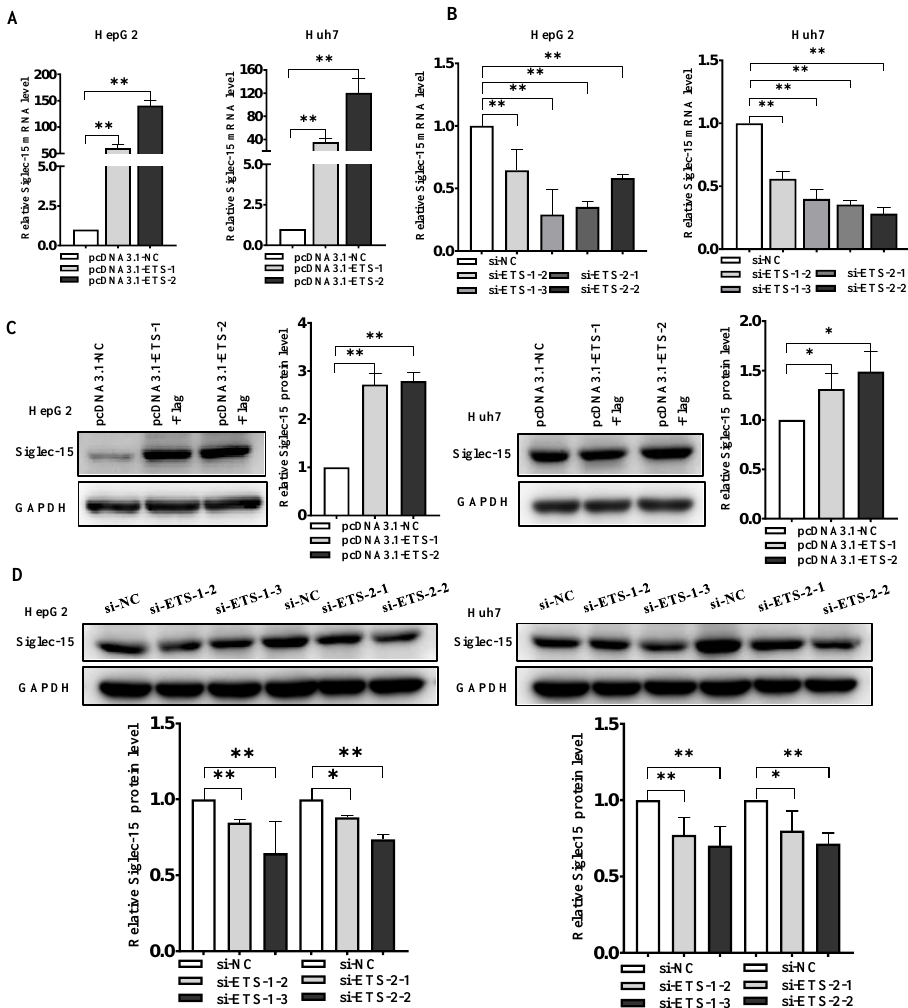
Figure 3. ETS-1 and ETS-2 enhances transcription and protein expression of Siglec-15 in HepG2 and Huh7 cells. ( A , B ) Effect of ETS-1 or ETS-2 overexpression ( A ) or knockdown ( B ) on Siglec-15 expression in the transfected HepG2 or Huh7 cells by quantitative real-time PCR. ( C , D ) Effect of ETS-1 or ETS-2 overexpression ( C ) or knockdown ( D ) on Siglec-15 expression in the transfected HepG2 or Huh7 cells by Western blot analysis. * p < 0.05; ** p < 0.01. NC stands for negative